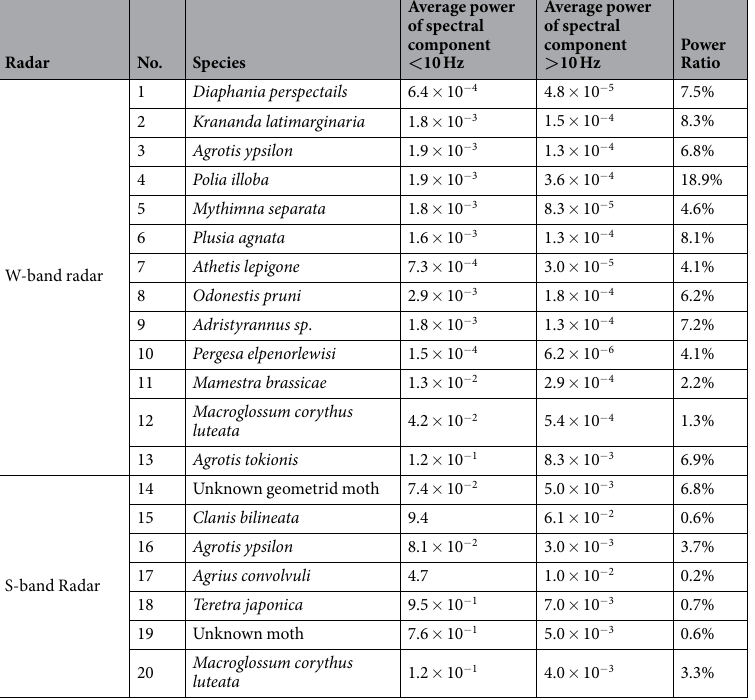
Table 1. Signal power statistics of different spectral components. Note: The “Power Ratio” in last column represents signal power ratio of spectral component lower than 10 Hz to spectral component higher than 10 Hz. In addition, note that W-band and S-band radars have different transmitted power and system gain. As no radar calibration is made, the given signal powers in the first two columns only represent relative quantized sample value, rather than the absolute backscattered signal intensities of insects. All the measured insects are moths